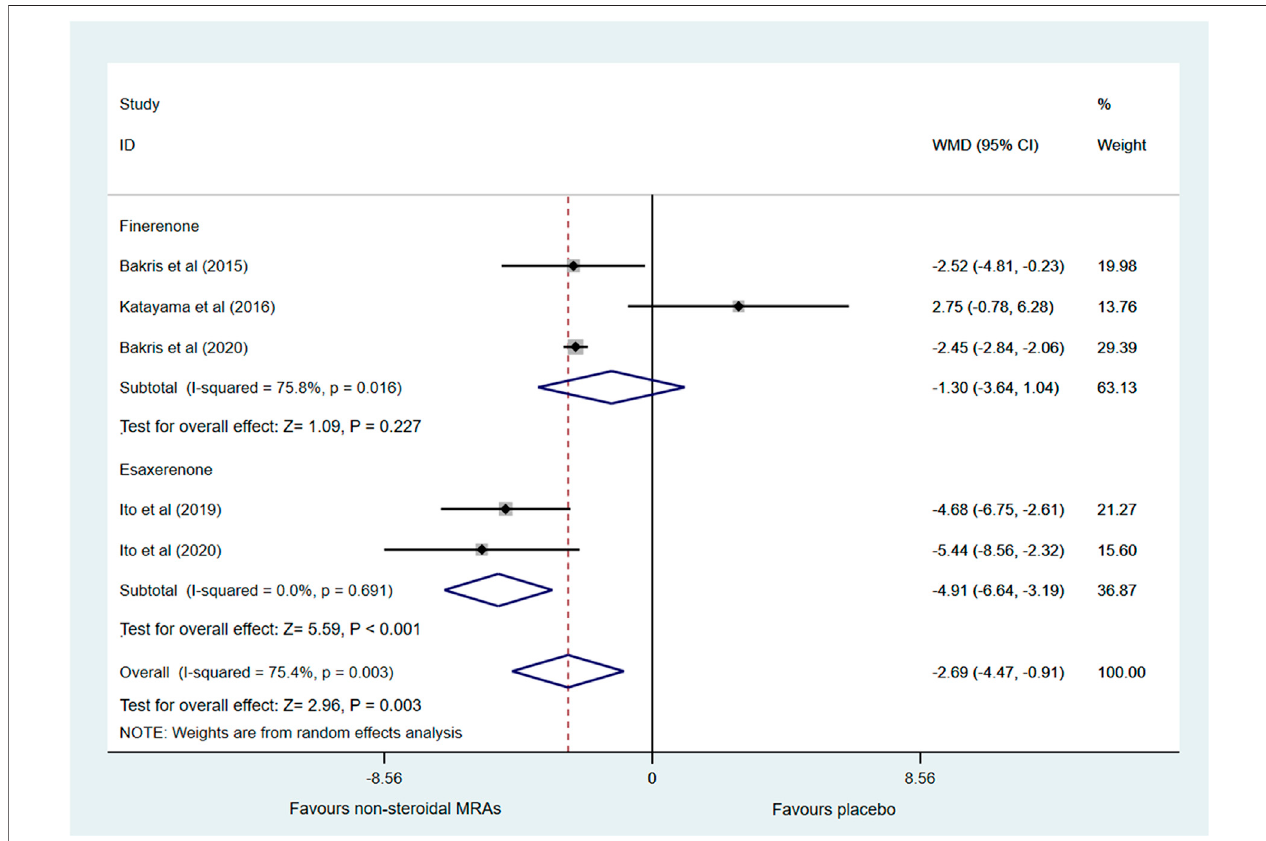
FIGURE 4 | Forest plot for the effect of non-steroidal MRAs on the changes in eGFR from baseline in patients with CKD and T2D. eGFR, estimated glomerular fi ltrationrate(expressedinmL/min/1.73 m 2 );WMD,weightedmeandifference;MRAs,mineralocorticoidreceptorantagonists;CKD,chronickidneydisease;T2D,type2